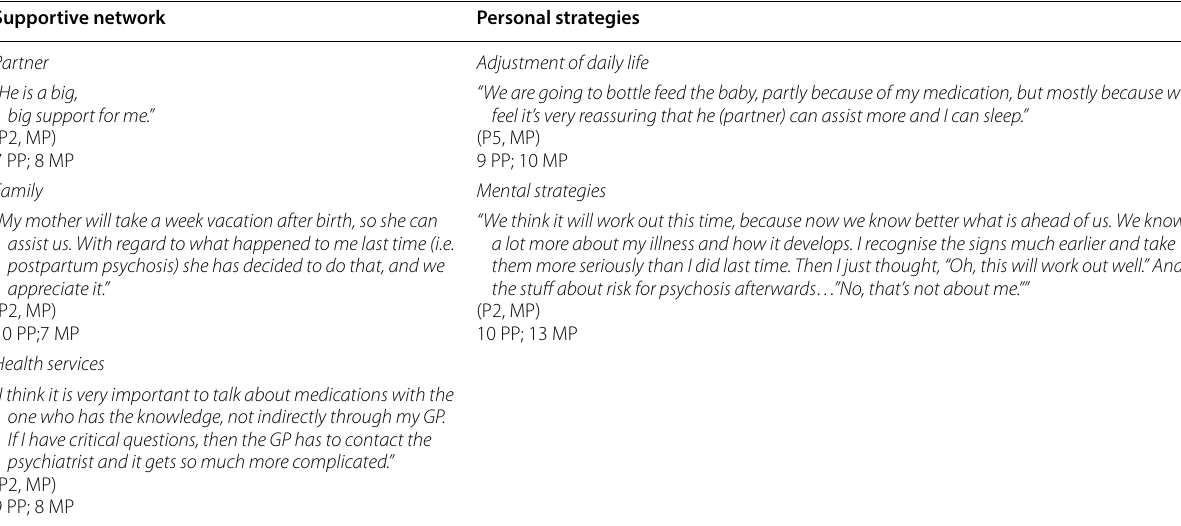
Table 4 Themes and subthemes of perinatal resources and preparations Supportive network Personal strategies